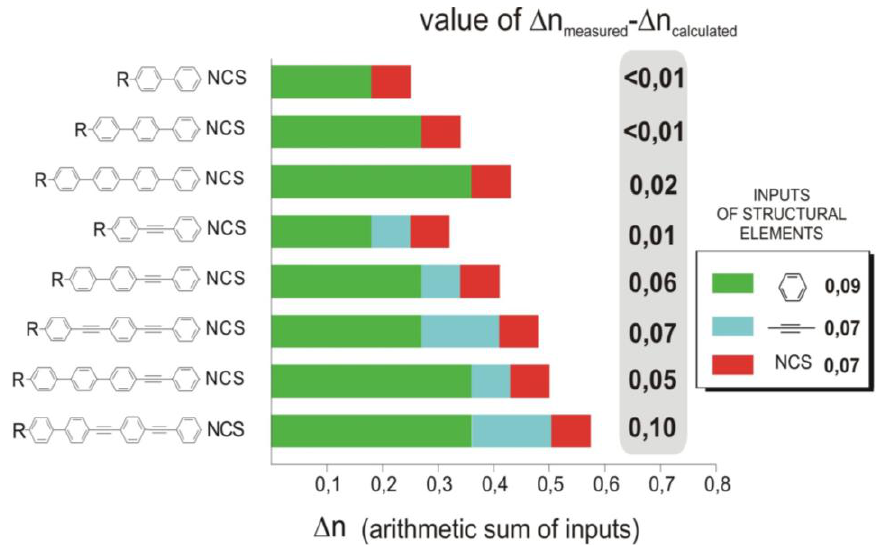
Figure 15. Predicted and observed birefringence values in differently conjugated compounds, consisting of benzene rings and triple bonds.